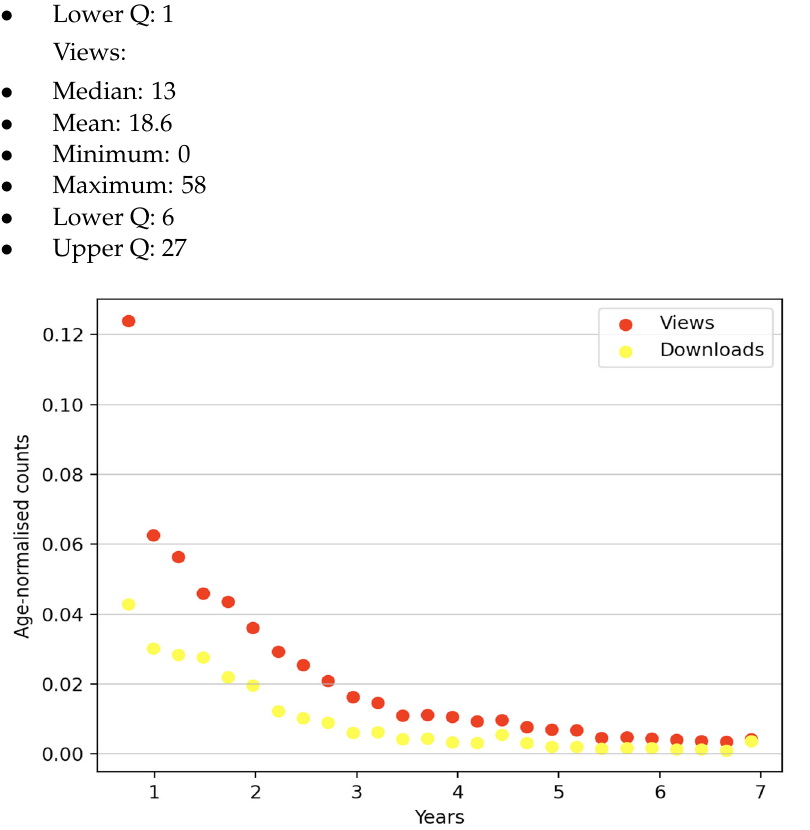
Figure A13. Humanities and social sciences datasets published in Zenodo (2015–2022): average total downloads and views over time (3-month ranges).